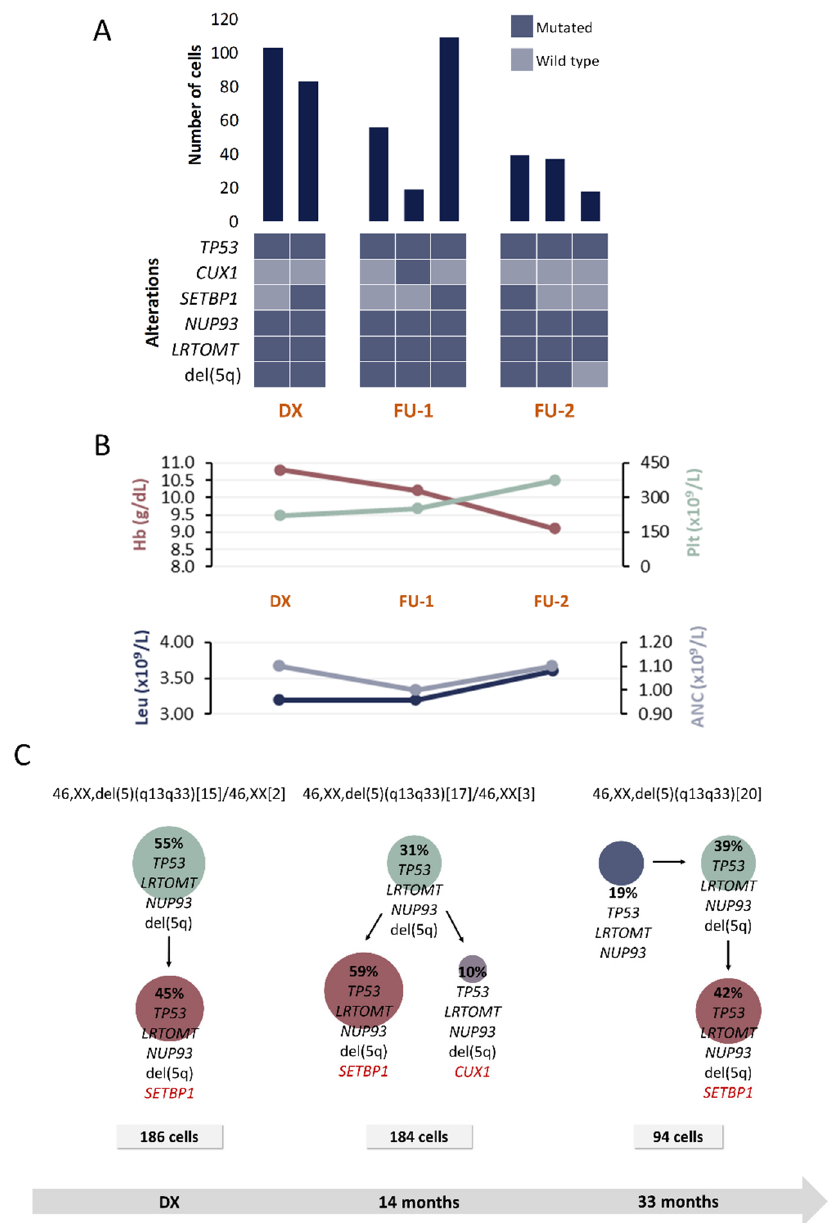
Figure 2. Clinical and molecular characteristics of patient P1. (A) Bar plot depicts the number of cells with a given genotype for each clone that was detected at the moment of diagnosis (DX), 1 st follow-up (FU-1) and 2 nd follow-up (FU-2). Heatmap below the bars indicates the genotype for each clone: dark blue and light blue are used to indicate the mutated or wild-type state, respectively. ( B) Hematological characteristics such as hemoglobin (Hb), platelet count (Plt), leukocyte count (Leu) and absolute neutrophil count (ANC) are indicated for each analyzed time point. ( C) Proposed clonal architecture, karyotype and number of analyzed cells for each time point is indicated. Color red distinguishes new acquired alterations in each clone.